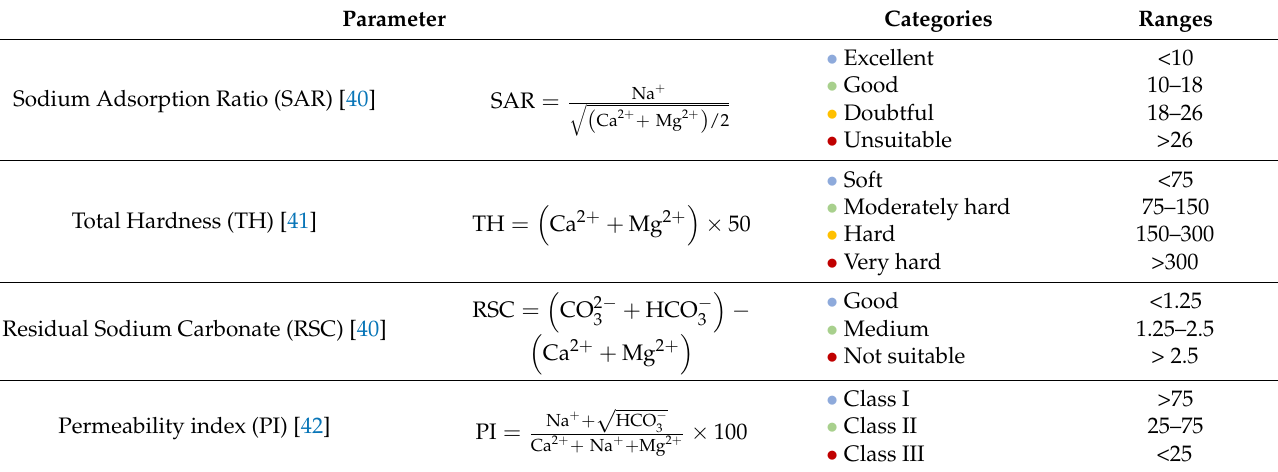
Table 1. Water quality classification as per different water quality